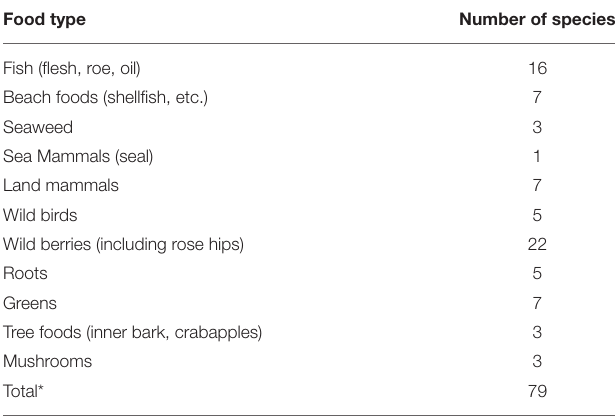
TABLE 1 | Summary of traditional wild food species harvested by Nuxalk Nation families. Food type